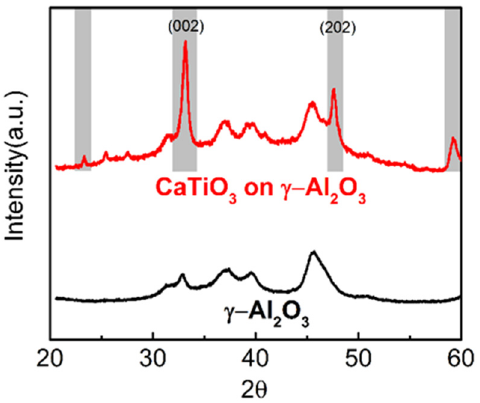
Figure 1. XRD patterns of bare Al 2 O 3 ( γ -phase, denoted as the black line) and the 18 wt% CaTiO 3 /Al2O 3 sample (denoted as the red line). Features shaded in grey correspond to peaks of the perovskite phase.